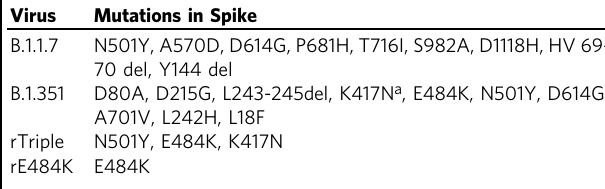
Table 1 Mutations in SARS-CoV-2 variants and